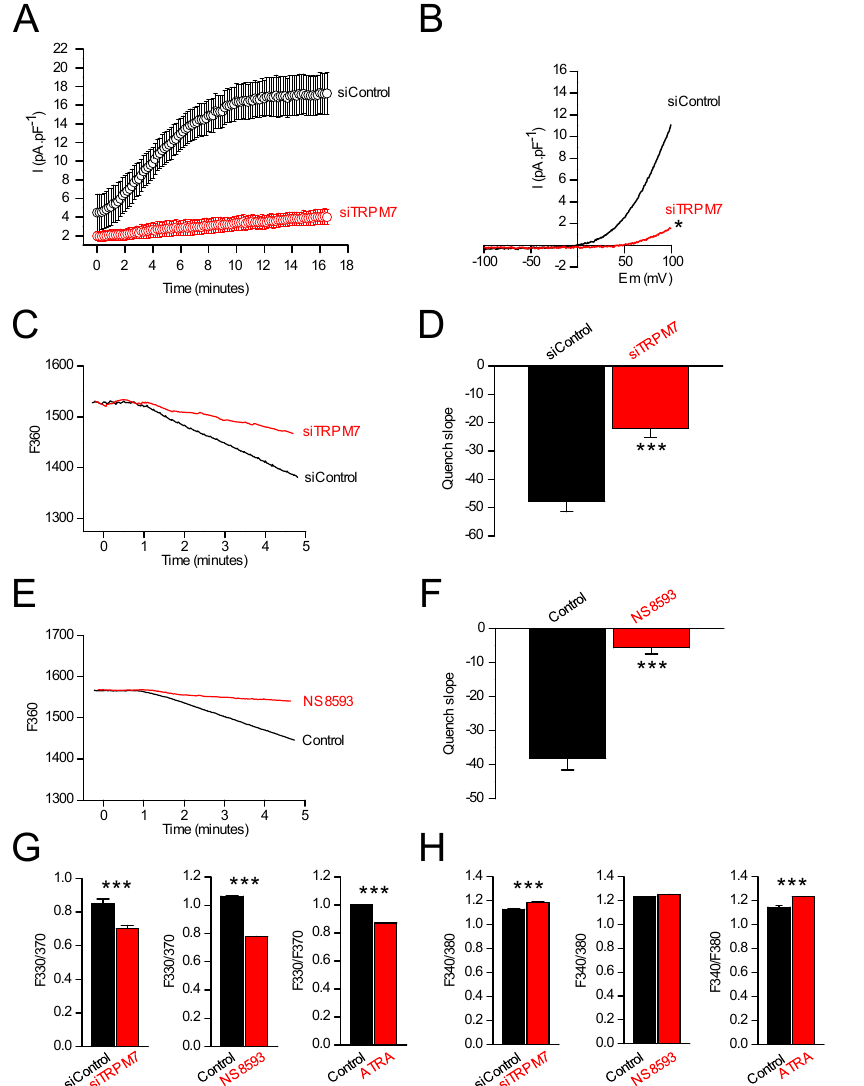
Figure 5. TRPM7 is active and regulates cytosolic Mg 2+ homeostasis in PSCs. ( A ) Development of an outward Magnesium-Inhibited Cation (MIC) current recorded at +100 mV during the dialysis of intracellular media by a 0-Mg intrapipette solution in PSCs transfected by a control siRNA ( n = 6) and in PSCs transfected by a siRNA targeting TRPM7 ( n = 4). ( B ) MIC currents are decreased in PSCs treated by a TRPM7 siRNA ( n = 4) compared to cells treated by a control siRNA ( n = 6). * indicates p < 0.05 (Mann–Whitney Rank Sum Test for the current-densities recorded at +100 mV). ( C ) Estimation of constitutive divalent cation entry by Mn 2+ -quenching in PSCs treated by a TRPM7 siRNA ( n = 19) compared to control cells ( n = 23). ( D ) Quantification of constitutive divalent cation entry after TRPM7 silencing. *** indicates p < 0.001 ( t -test). ( E ) Estimation of constitutive divalent cation entry by Mn 2+ -quenching in PSCs treated by NS8593 ( n = 34) compared to control cells ( n = 30). ( F ) Quantification of constitutive divalent cation entry after TRPM7 block. *** indicates p < 0.001 ( t -test). ( G ) Quantification of MagFura-2 fluorescence ratio after treatment with siTRPM7 ( n = 87 for siTRPM7 and n = 92 for siControl), after treatment with NS8593 ( n = 32 for treated cells and n = 39 for control), and after treatment with ATRA ( n = 40 for treated cells and n = 32 for control). *** indicates p < 0.001 ( t -tests). ( H ) Quantification of Fura-2 fluorescence ratio after treatment with siTRPM7 ( n = 47 for siTRPM7 and n = 36 for siControl), after treatment with NS8593 ( n = 23 for treated cells and n = 34 for control), and after treatment with ATRA ( n = 52 for treated cells and n = 27 for control). *** indicates p < 0.001 ( t